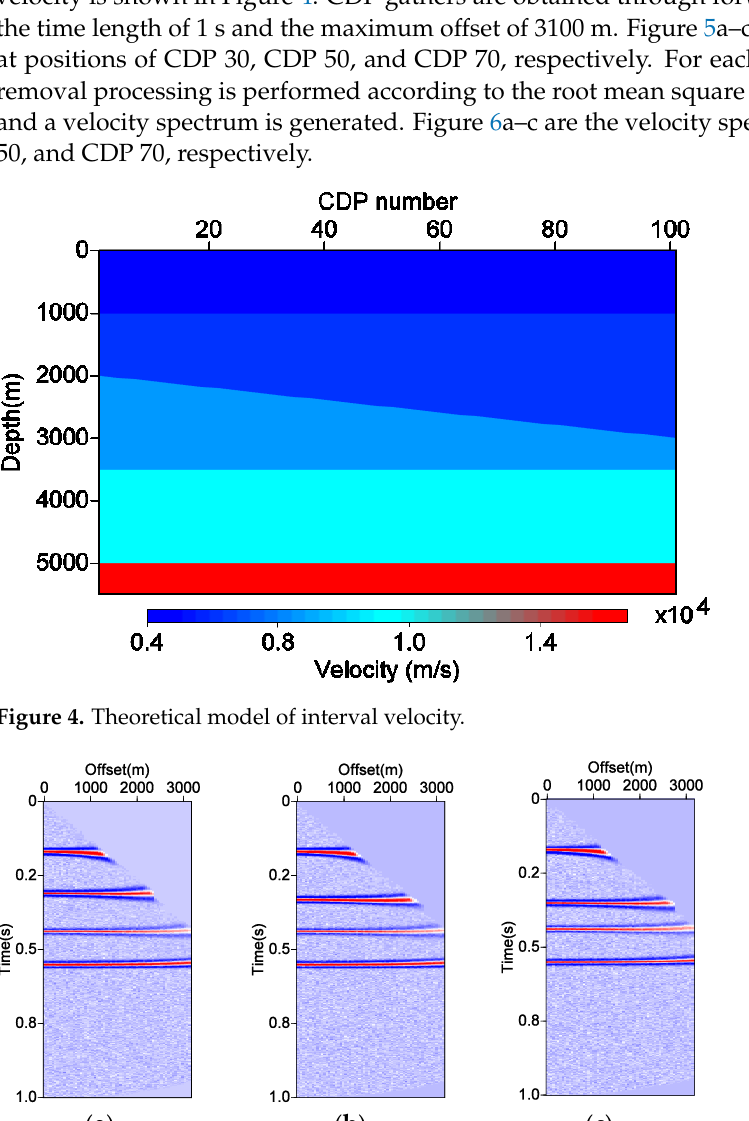
( c ) Figure 6. Velocity spectrum. ( a ) CDP 30; ( b ) CDP 50; ( c ) CDP 70. 3.2. Model Training The velocity spectrum of CDP 50 is used as the tracking target of the training da- taset. As shown in Figure 6b, there are four energy clusters. We take the energy cluster of 0.2–0.35 s (as shown in Figure 7a) as an example to explain the generation of a training dataset. Based on the energy cluster of 0.2–0.35 s, 100 training samples labeled as posi- tive are generated by stretching, compression, and filtering. Figure 7b,c are examples of images after deformation and stretching, and Figure 7d–f are examples of images after filtering. The positive samples are set to 1. The energy clusters of 0.1–0.2 s, 0.35–0.5 s, and 0.5–0.65 s in Figure 6b are stretched, compressed, and filtered to generate 300 training samples marked as negative, as shown in Figure 8. The negative samples are set to 0. The training process has 500 iterations, and the learning rate is set to 0.0001. After this training process is completed, set the tracking target as the energy cluster of 0.35–0.5 s, and set the energy clusters of 0.1–0.2 s, 0.2–0.35 s, and 0.5–0.65 s as the negative samples, and then repeat the same training pro- cess.